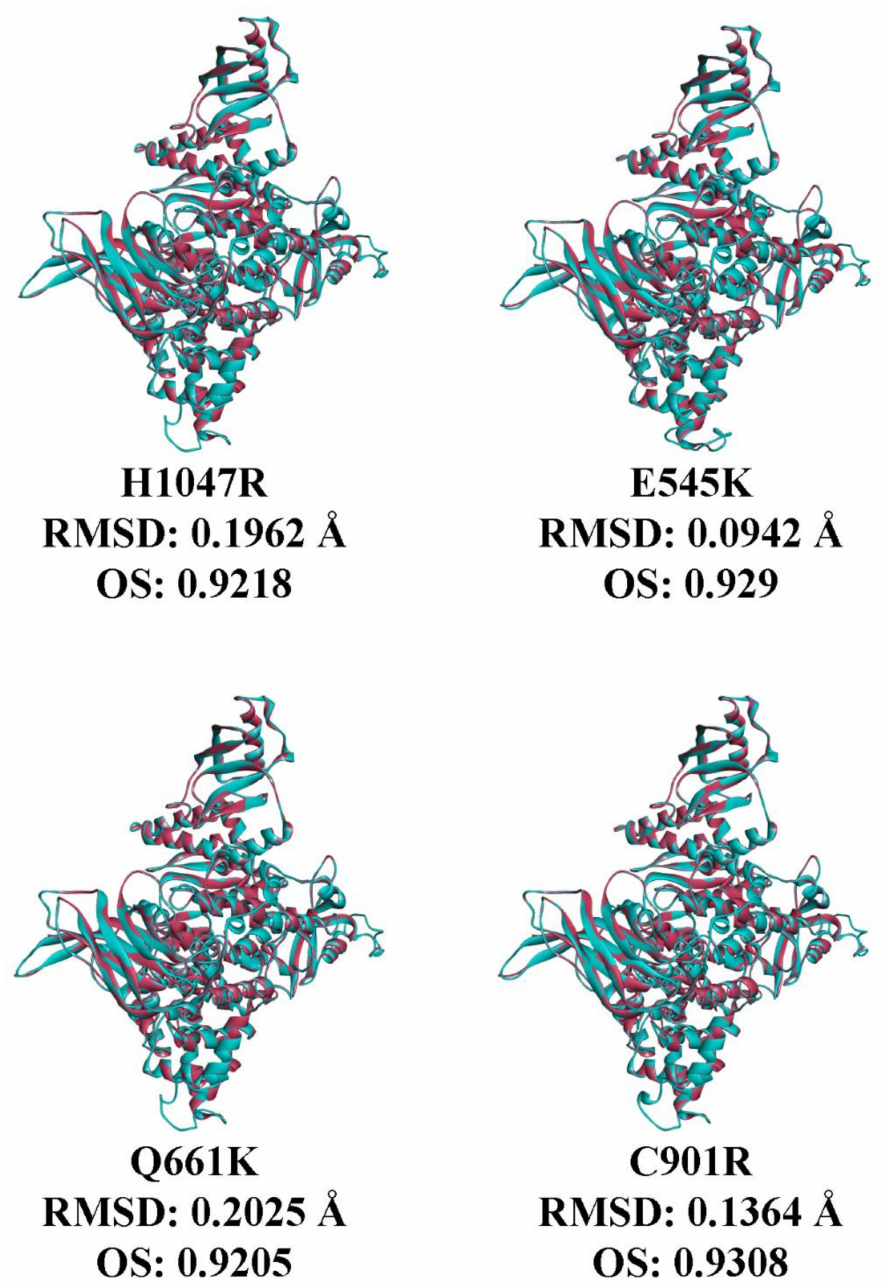
Figure 6. Superposition of modeled PIK3CA mutations (cyan ribbon) with the solved crystal structure of human wild type PIK3CA (PDB ID: 4L1B; red ribbon). Global main chain root mean square distance (RMSD) and overlay similarity (OS) values were also predicted via sequence alignment function for each mutant in comparison with the wild type. RMSD: root-mean-square distance; OS: overlay similarity; PIK3CA: phosphatidylinositol 3-kinase, catalytic subunit